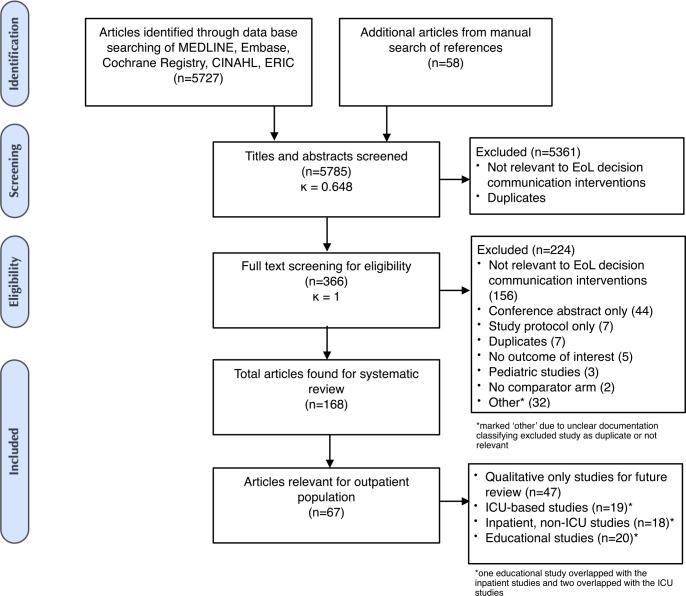
Flowchart of study screening, eligibility, and inclusion.